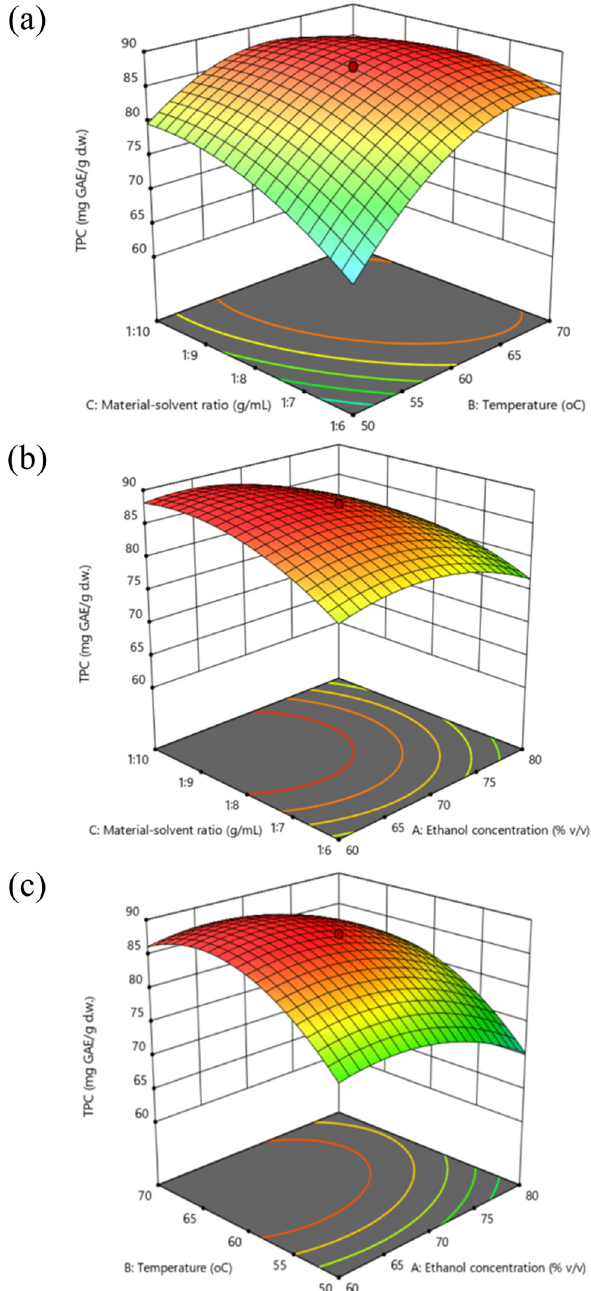
Figure 6: Response surface plots for the impact of ( a ) ethanol/ temperature, ( b ) ethanol/material – solvent ratio, and ( c ) material – solvent ratio/temperature.